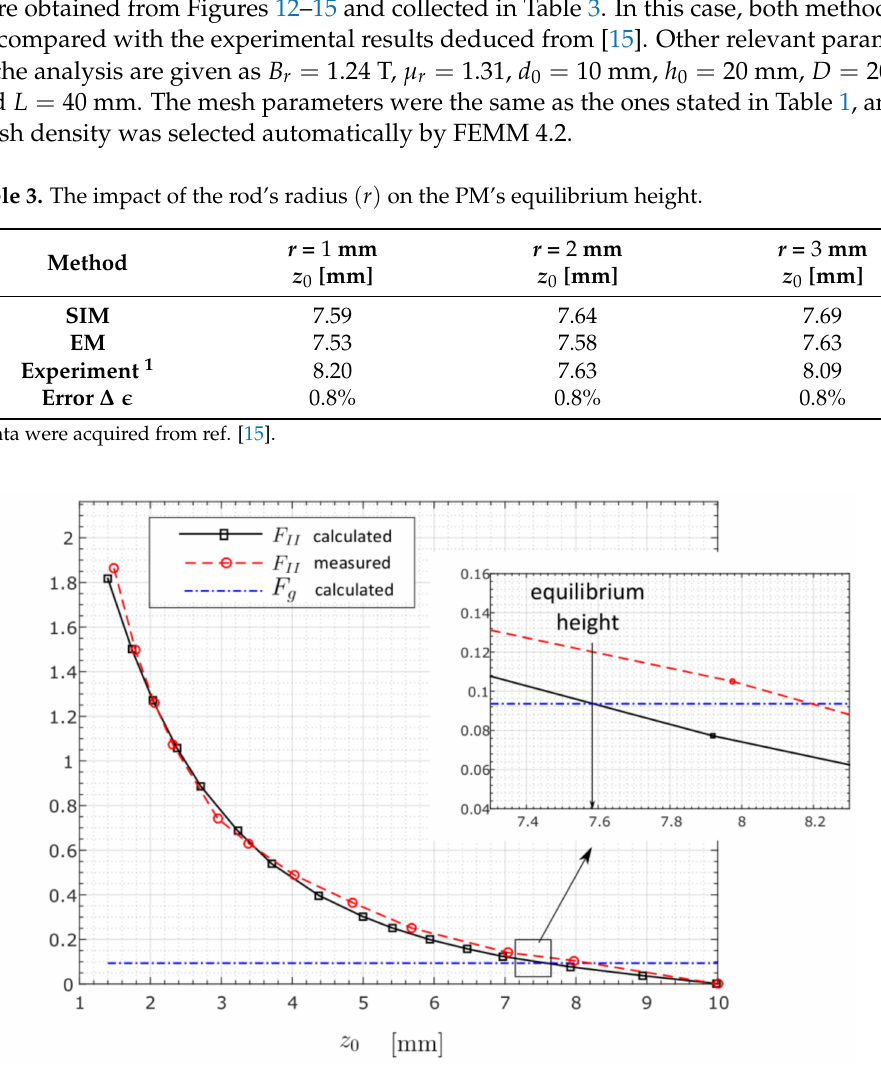
Figure 12. The measured and calculated curves of magnetic levitation force F II for the case r = 1 mm. The force was calculated by the SIM. An intersection between the gravitational F g and mag-netic levitation force F II is shown in the magnified window. Measured data were acquired from ref.